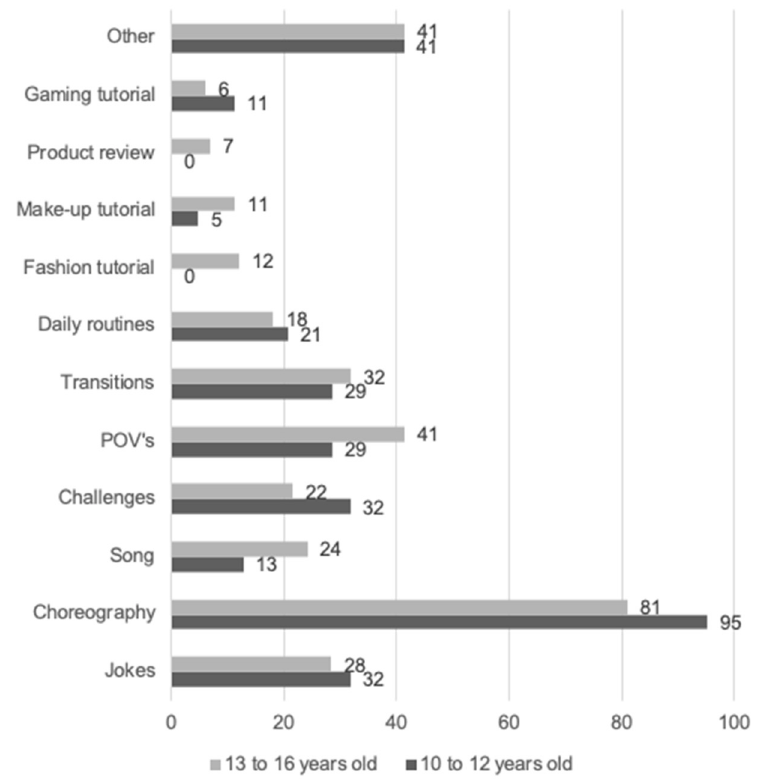
Figure 7. Types of content created on TikTok (in percentage).